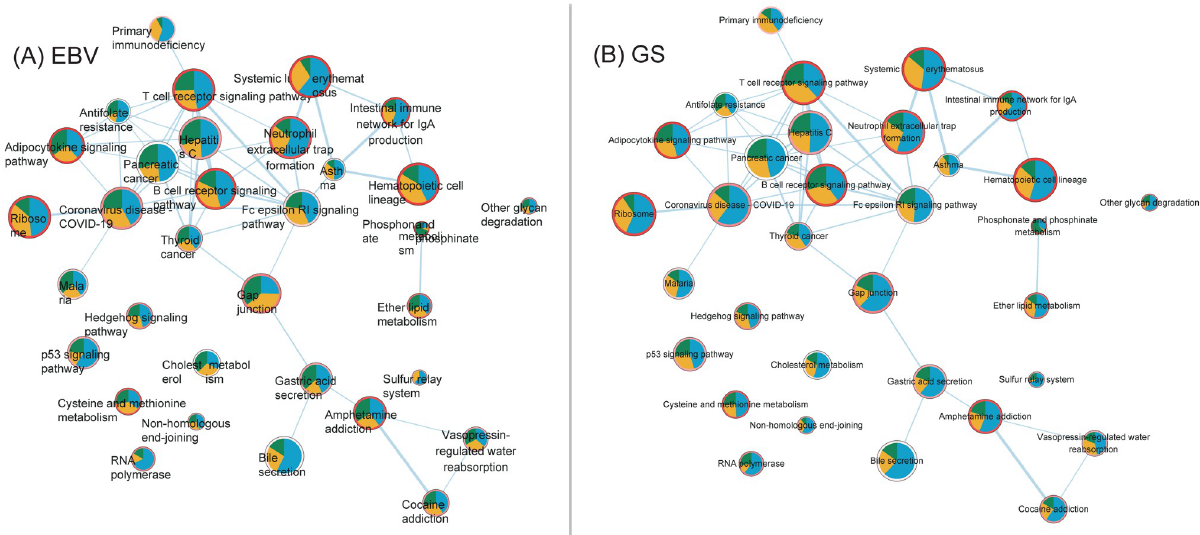
Fig 16. The pathway networks of STAD subtypes. Here, each node represents a pathway, where the pie chart indicates the OCR and the border the survival p-value. The OCR values of the STAD subtypes (A) CIN and (B) GS were visualized.